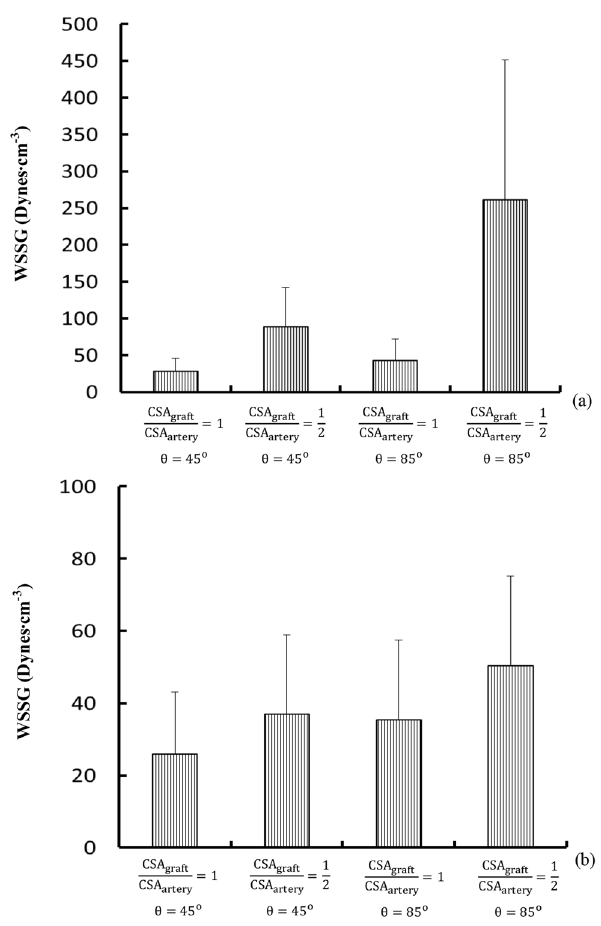
Figure 8. (a) Mean ± SD WSSG (Unit: Dynes ? cm 2 3 ) in Region B (averaged over all nodes in the region), (b) Mean ± SD WSSG in Region D (averaged over all nodes in the region). Region B has ~ 1 and h =45 u ; surface area of 1.2, 2.8, 3.1, and 2.4 mm 2 for CSA graft CSA artery CSA graft ~ 1 ~ 1 and h =85 u ; and CSA graft ~ 1 and h =45 u ; CSA graft and 2 2 CSA artery CSA artery CSA artery h =85 u , respectively. Region D has surface area of 2.4, 3.3, 4.2, and 4.3 mm 2 ,